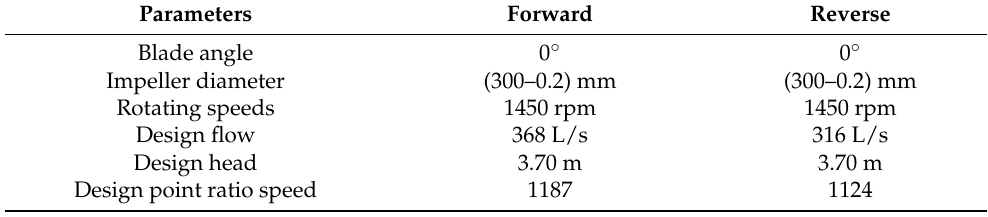
Table 1. Parameters of design working conditions of “S” shaped airfoil bidirectional axial flow pump.